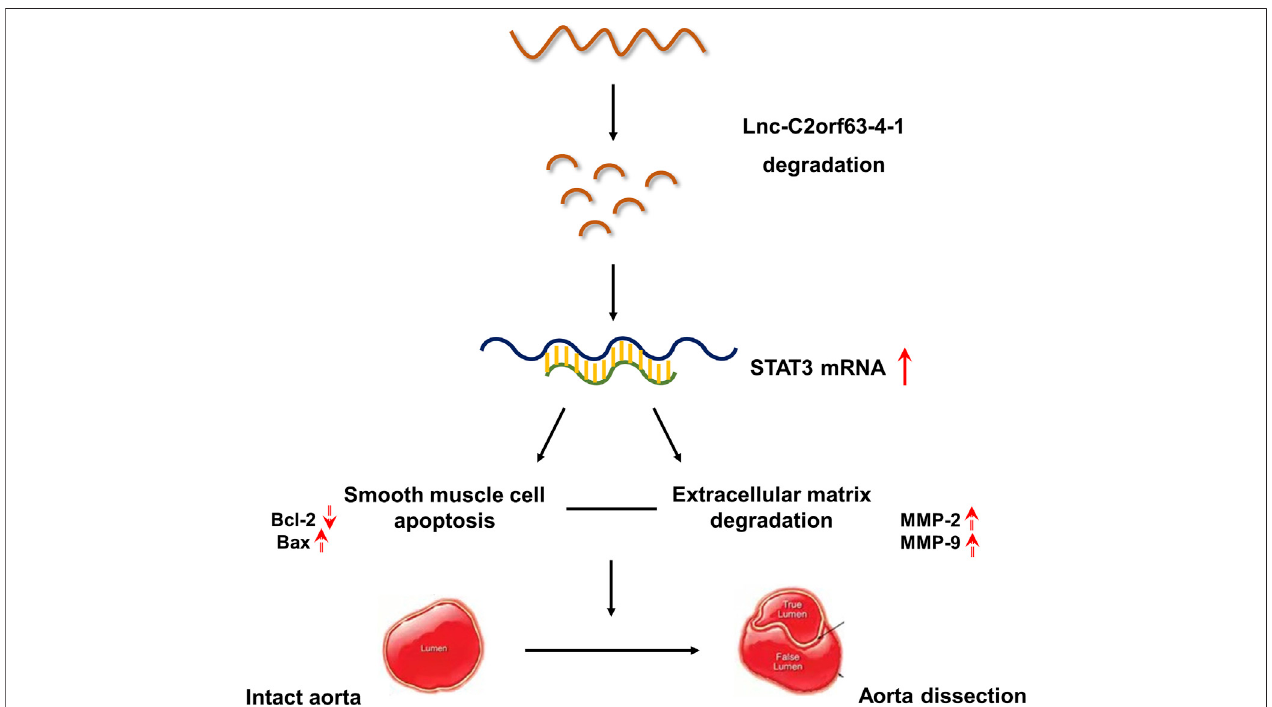
GRAPHICAL ABSTRACT | Our studies indicates that lnc-C2orf63-4-1 was a novel regulator of smooth muscle cell survival during the development of aortic aneurysm and dissection (AAD). Under pathological stimulation, decreased levels of lnc-C2orf63-4-1 bind to the promoter region of STAT3 resulting in enhancement of STAT3 mRNAstabilization,whichcanactivatedownstream apoptosissignaling (indicatedbyelevated BAXanddecreasedBCL2levels),matrixmetalloproteinasefamily (indicated by elevated MMP-2 and MMP-9 levels) and interstitial fi brosis factors (indicated by elevated type I and type III collagen levels). Taken together, these events trigger smooth muscle cell apoptosis, degradation of ECM, and fi brosis, which induces vascular remodeling and aggravating AAD development.